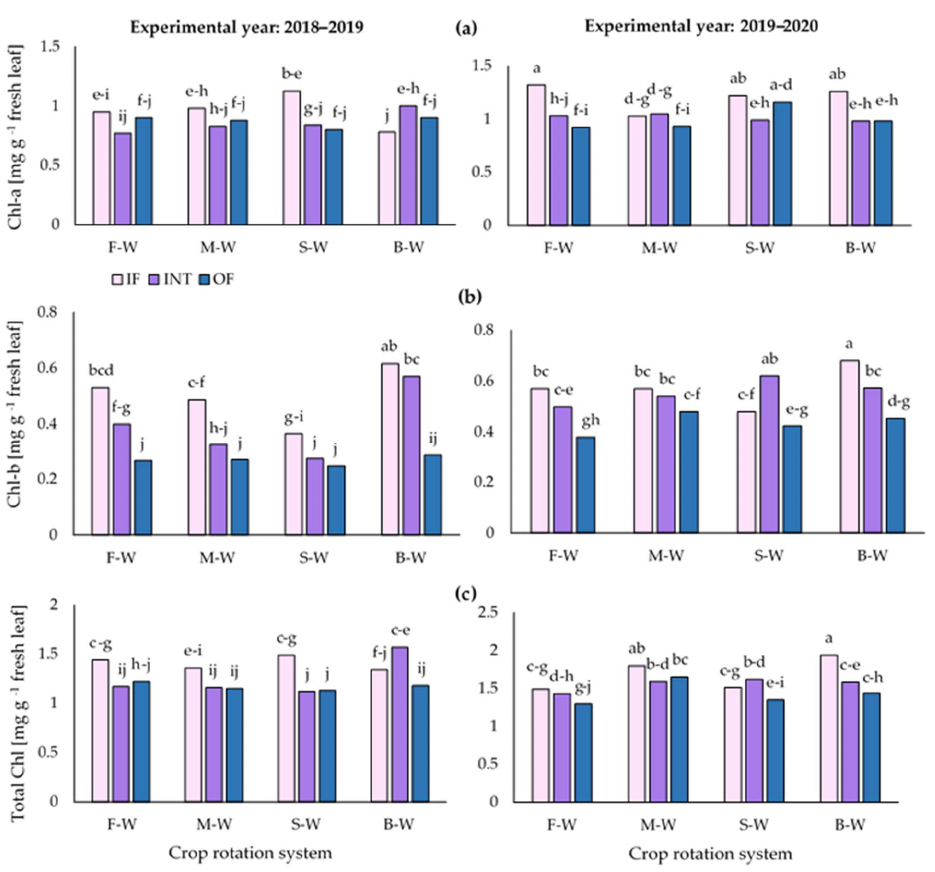
Figure 2. Effects of the interaction between three farm management practices (intensive, IF; organic, OF; and integrated, INT) and four crop rotation systems (fallow-wheat, F-W; maize-wheat, M-W; sesame-wheat, S-W; and mung bean-wheat, B-W) on ( a ) chlorophyll-a, ( b ) chlorophyll-b and ( c ) total chlorophyll at flowering time during the two-year experiment. Means were compared by Duncan’s test, and different letters above each bar indicate a significant difference at p ≤ 0.05.